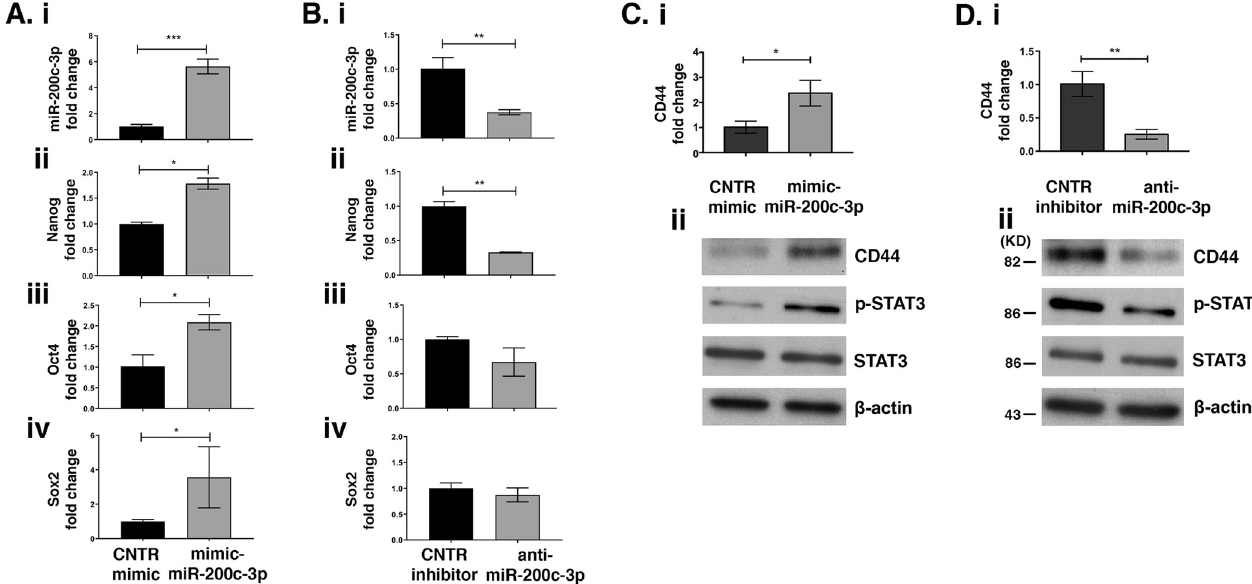
Fig 3. MiR-200c-3p regulates the expression of stemness markers. A. qRT-PCR of miR-200c-3p (i), Nanog (ii) , Oct4 (iii) and Sox2 (iv) in ASCs at P4 transfected with miR-200c-3p mimic. The fold change of miR-200c-3p was normalized to U6 and that of stemness markers to GAPDH. SD ± is the mean of three experiments and the p values were calculated with unpaired t test, � p < 0.05, ��� p < 0.001. B. qRT-PCR of miR-200c-3p (i) in ASCs transfected with anti- miR-200c-3p. Nanog (ii) , Oct4 (iii) and Sox2 (iv) expressions were normalized to GAPDH. SD ± is the mean of three experiments and the p values were calculated with unpaired t test, �� p < 0.01. C. CD44 mRNA was detected by qRT-PCR (i) and protein expression of CD44, p-STAT3 and STAT3 was detected by WB (ii) , in mimic-miR-200c-3p transfected ASCs. D. CD44 mRNA was detected by qRT-PCR (i) and protein expression of CD44, p-STAT3 and STAT3 was detected by WB (ii) , in anti-miR-200c-3p transfected ASCs. GAPDH was used as housekeeping for qRT-PCR and β -actin in WBs, as a loading control. SD ± is the mean of three experiments and the p values were calculated with unpaired t test, � p < 0.05, �� p <